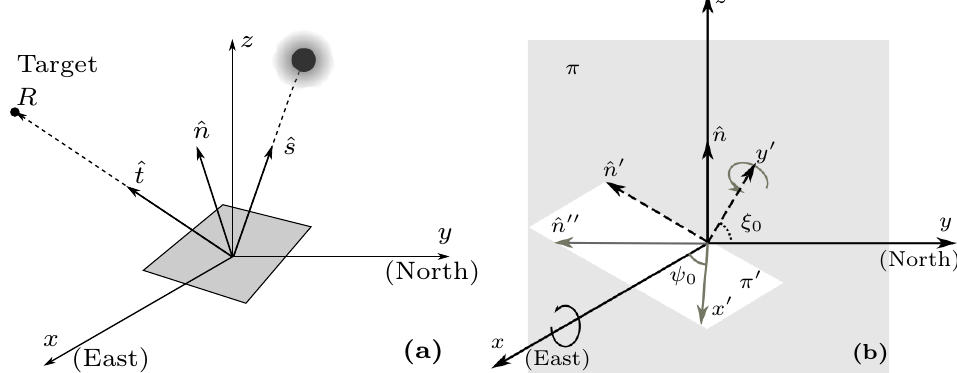
Figure 3. Global reference system showing the solar vector ˆ s , the mirror normal ˆ n , and the target vector ˆ t ( a ). The ξ 0 and ψ 0 rotations of the central facet for the heliostat array tracking ( b